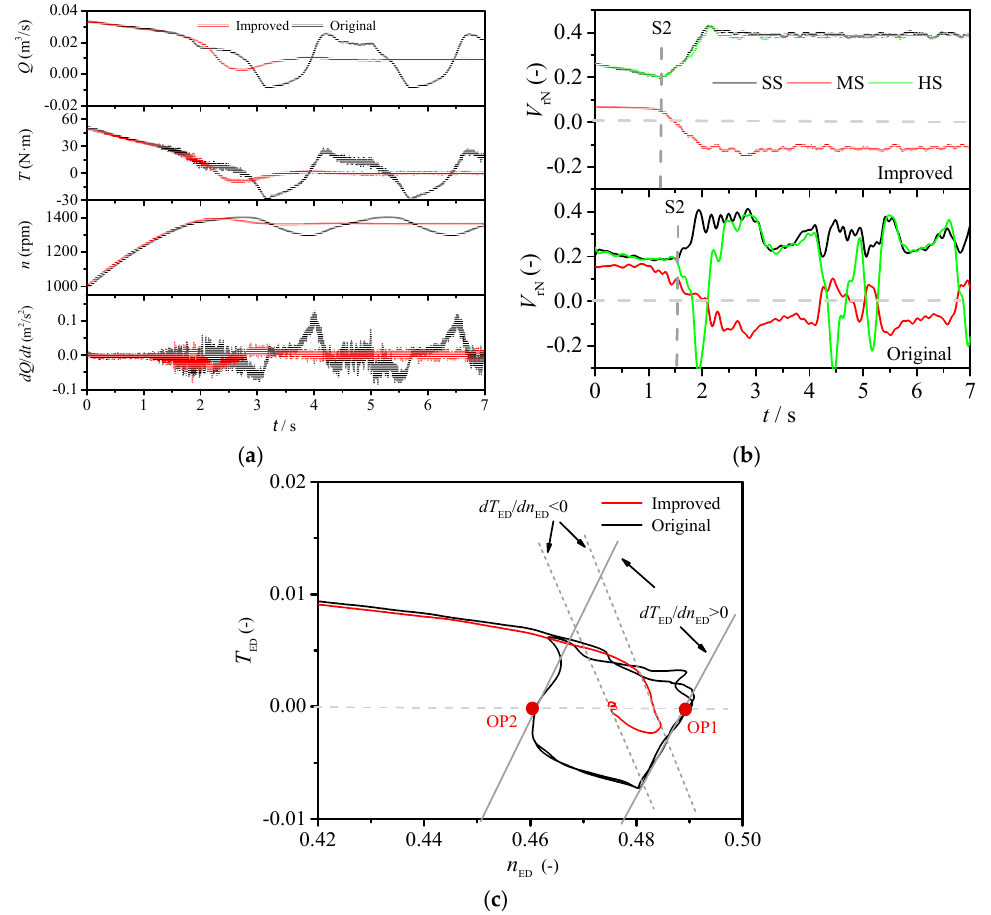
Figure 16. The dynamic characteristic between the improved and the original cases during runaway process at 9° GVO. ( a ) Transient parameters; ( b ) transient radial velocities; ( c ) dynamic trajectories.